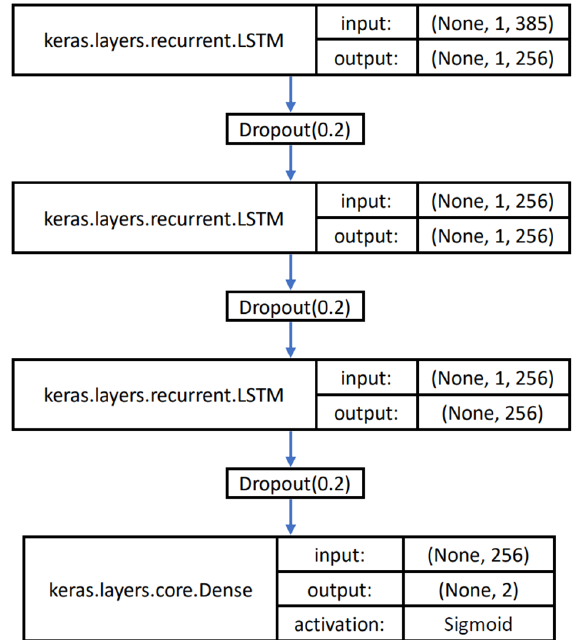
Figure 7. Model structure and parameters.